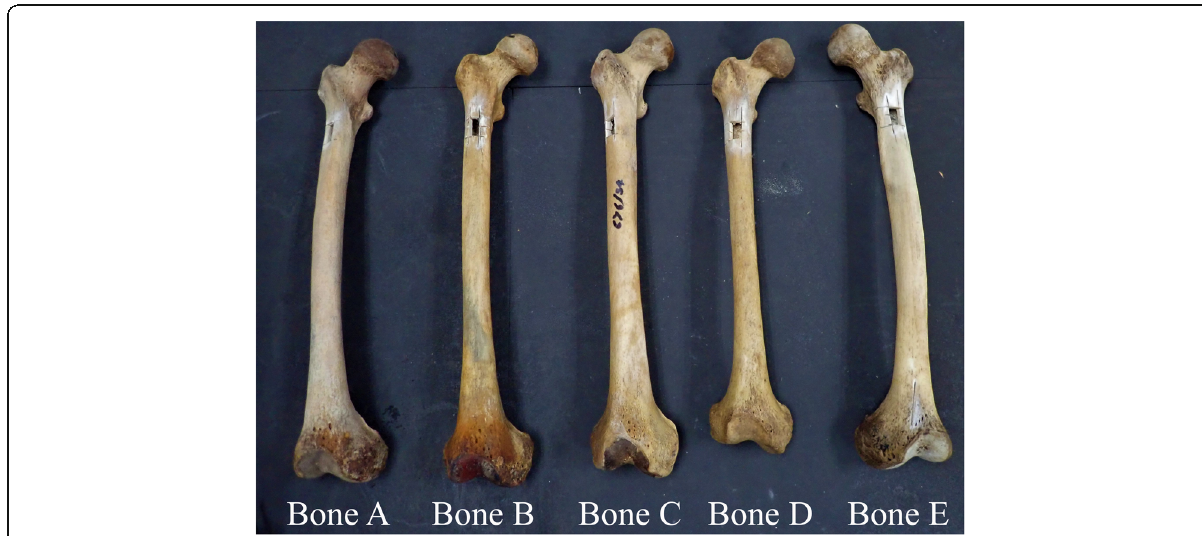
Fig. 1 The physical characteristics of bones B and D were relatively yellow-liked color on the external surface while bones A, C, and E were relatively white and yellow. Color changes on the external surface of the bones were probably caused by sun